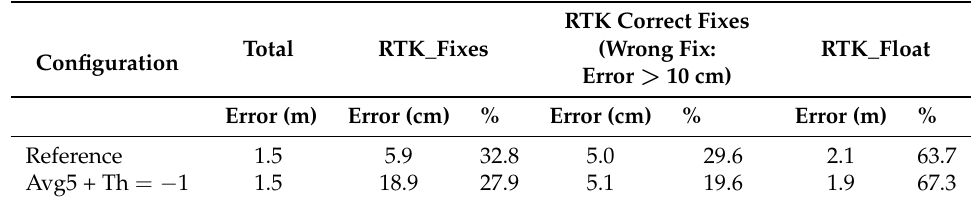
Table 2. Foliage scenario: PVT results for the best configuration in terms of exclusion threshold and average configuration (i.e., Avg5 and Threshold = −